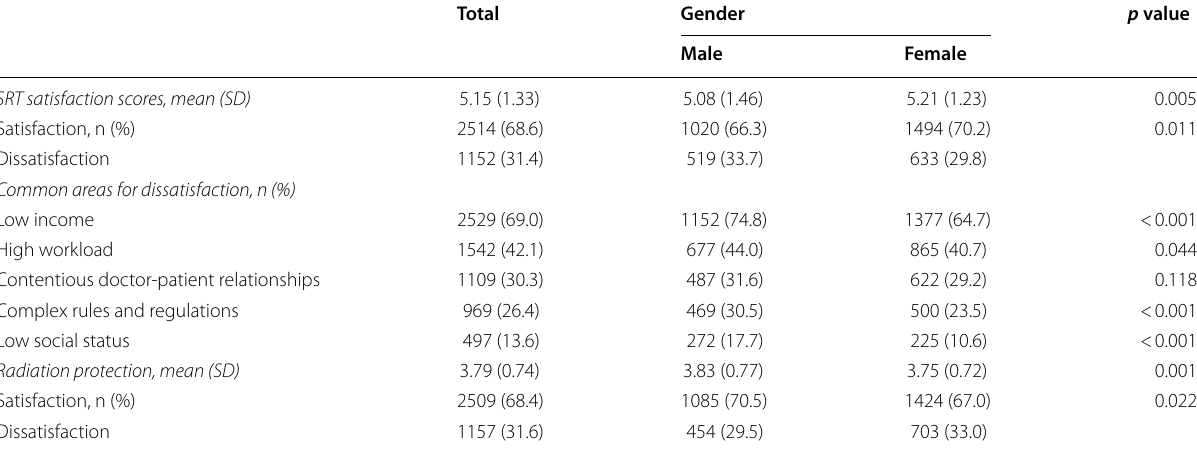
Table 2 Prevalence of SRT satisfaction in a sample of radiology residents in